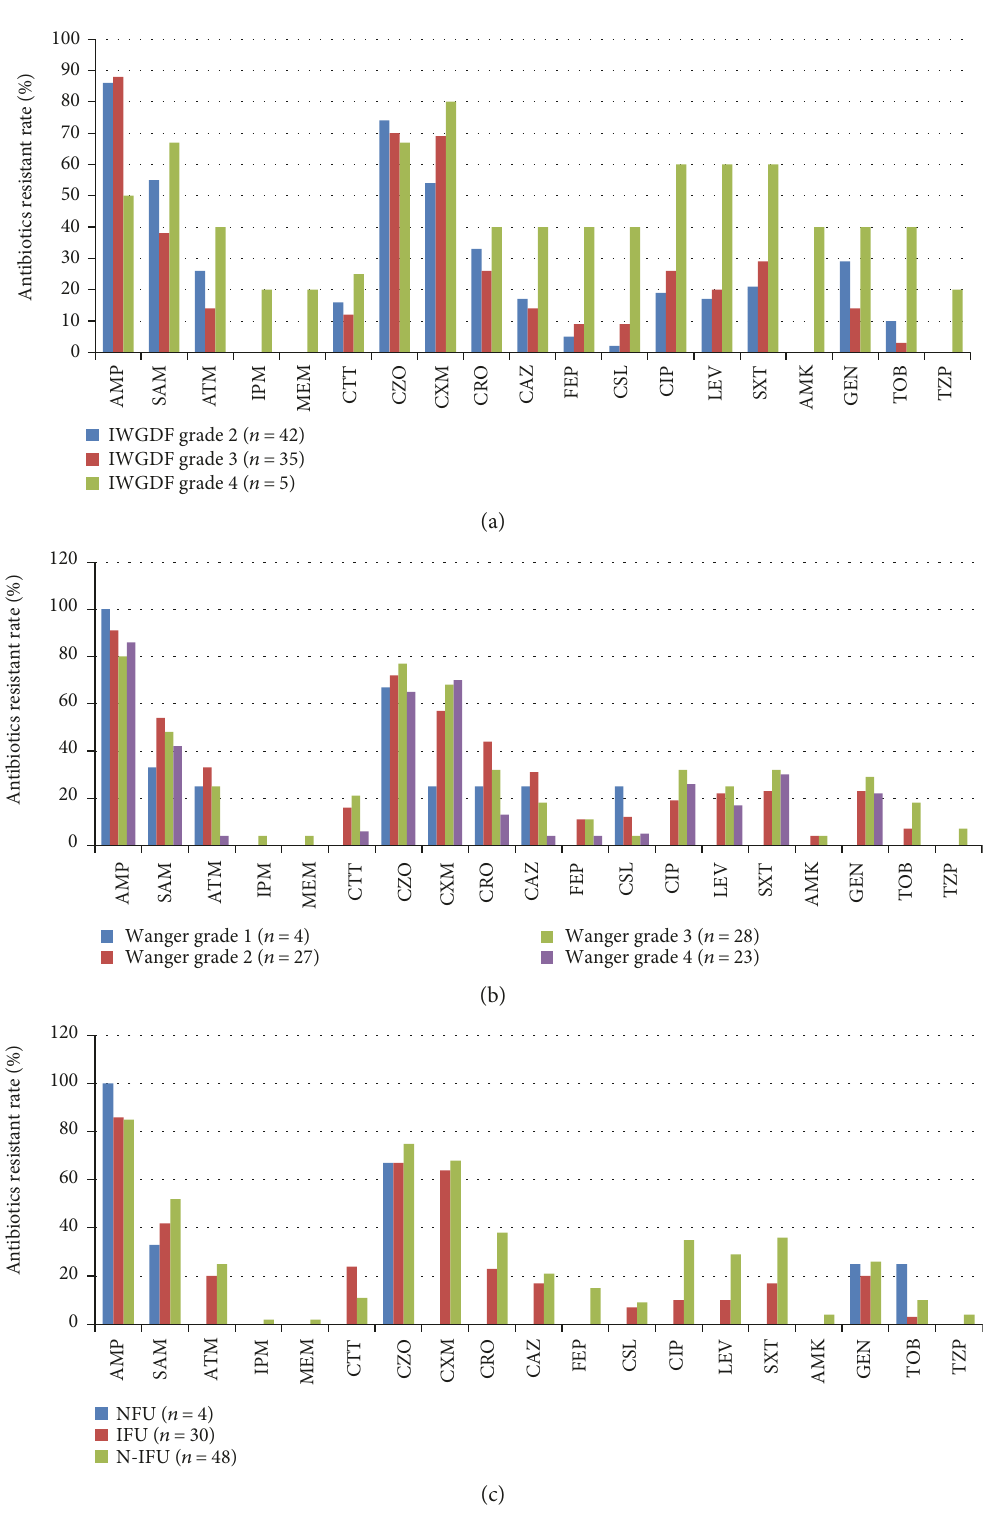
Figure 3: Antibiotic resistance rates of Enterobacteriaceae isolated in DFI in di ff erent Wagner ’ s grades, IDSA/IWGDF grades, and DFU types. (a) Antibiotic resistance rates of Enterobacteriaceae isolated in di ff erent IDSA/IWGDF grades ’ DFIs; (b) antibiotic resistance rates of Enterobacteriaceae isolated in di ff erent Wagner ’ s grades ’ DFIs; (c) antibiotic resistance rates of Enterobacteriaceae isolated in di ff erent DFU types. AMP, ampicillin; SAM, ampicillin/sulbactam; ATM, aztreonam; IPM, imipenem; MEM, meropenem; CTT, cefotetan; CZO, cephazolin; CXM, cefuroxime; CRO, ceftriaxone; CAZ, ceftazidime; FEP, cefepime; CSL, cefoperazone/sulbactam; CIP, cipro fl oxacin; LEV, levo fl oxacin; SXT, trimethoprim/sulfamethoxazole; AMK, amikacin; GEN, gentamicin; TOB, tobramycin; TZP,